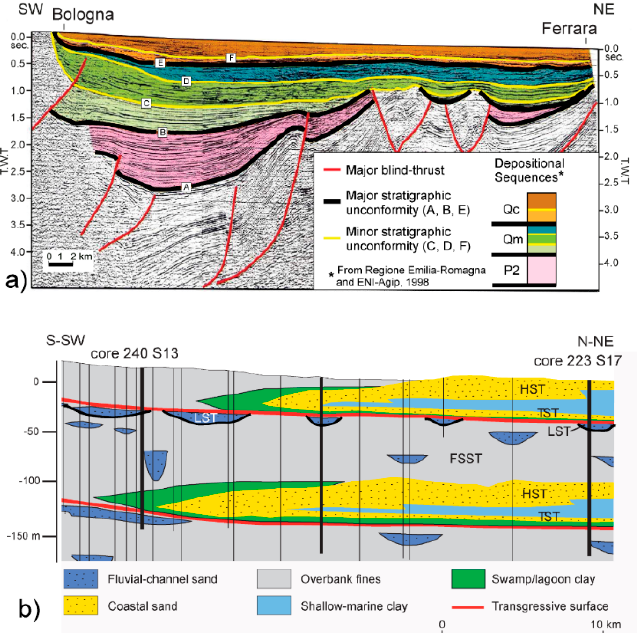
Figure 2. Stratigraphic architecture of the sedimentary infill of the Po Basin. Section traces are reported in Figure 1. ( a ): interpreted seismic profile showing the Pliocene (P)-Quaternary (Q) depositional sequences, related stratigraphic unconformities (A–F lines) and the major blind thrusts (red lines) as identified by [49]. T.W.T.: two-way travel time. ( b ): glacio-eustatic driven, cyclic sedimentation pattern of the Po coastal plain over the ~130 kyrs BP, as revealed by the facies architecture of the uppermost ~130 m (from [27]). Red lines highlight the Transgressive Surfaces (TSs) that mark the lower boundary of coastal wedges attributed to the last and present-day interglacials (MIS 1 and MIS 5e, respectively). Coastal wedges include transgressive (TST) and highstand (HST) deposits, while alluvial deposits compose the falling-stage and lowstand systems tracts (FSST +